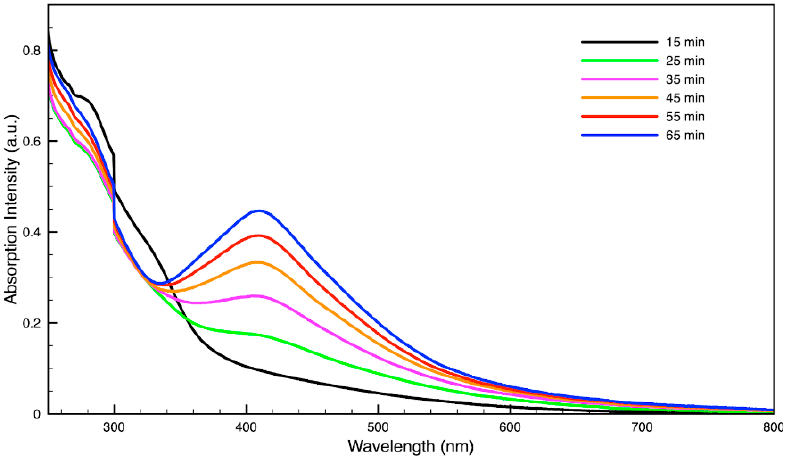
Figure 6. Time evolution of absorption spectrum of silver (Ag) nanoparticles during synthesis using dark roast, spent espresso coffee grounds (SDE).